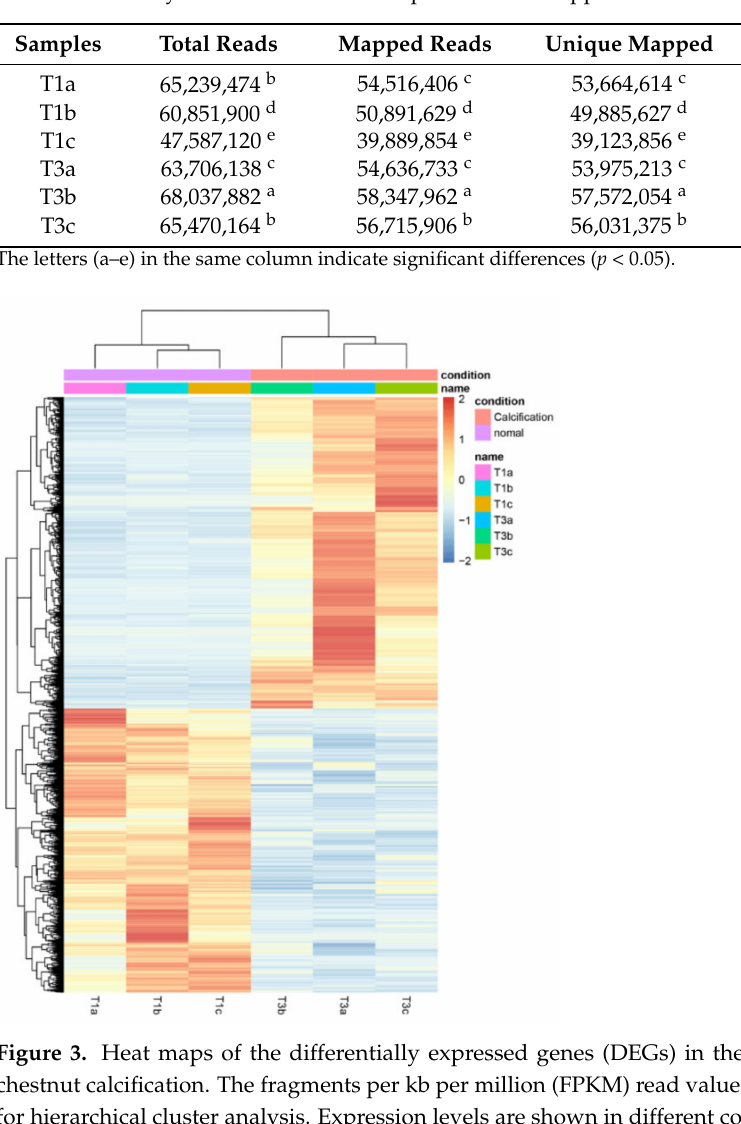
Table 2. Summary of the chestnut transcriptome reads mapped to the reference genes.